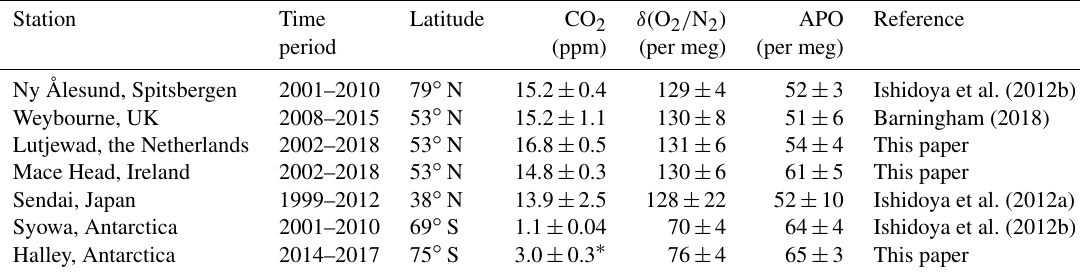
Table 5. Comparison of the seasonal amplitudes of CO 2 , δ (O 2 / N 2 ), and APO at various locations in the world.